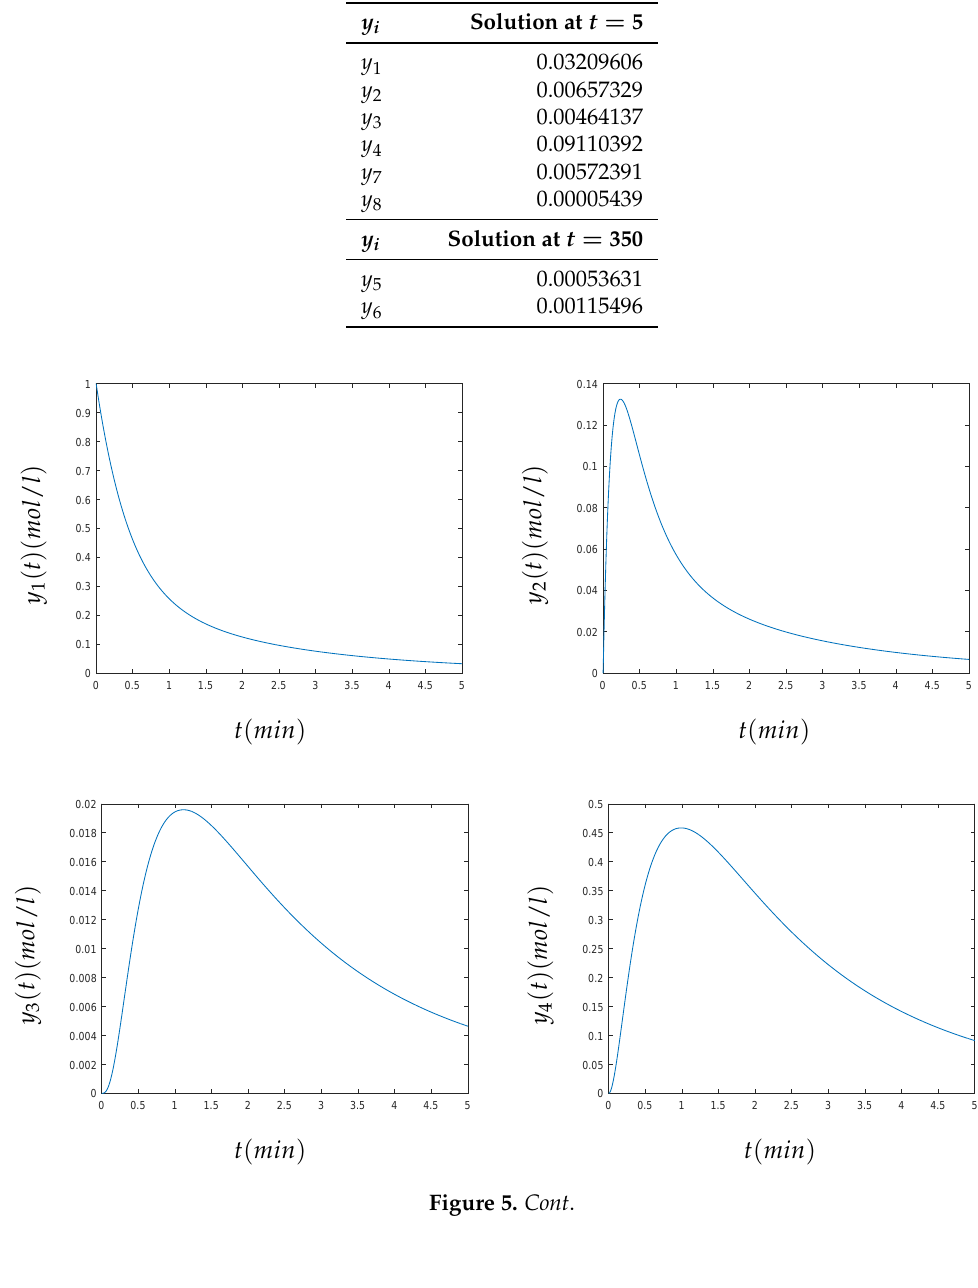
Table 3. Results of the Hires problem at t = 5 for y 1 , y 2 , y 3 , y 4 , y 7 , y 8 and at t = 350 for y 5 and y 6 .